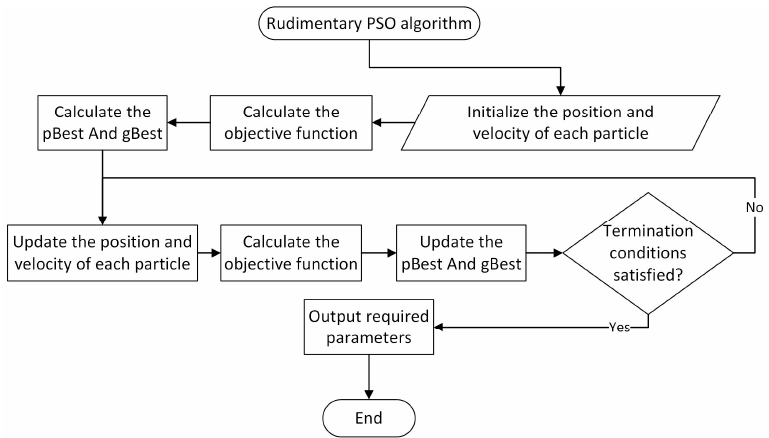
Figure 3. Flow chart of rudimentary PSO algorithm.